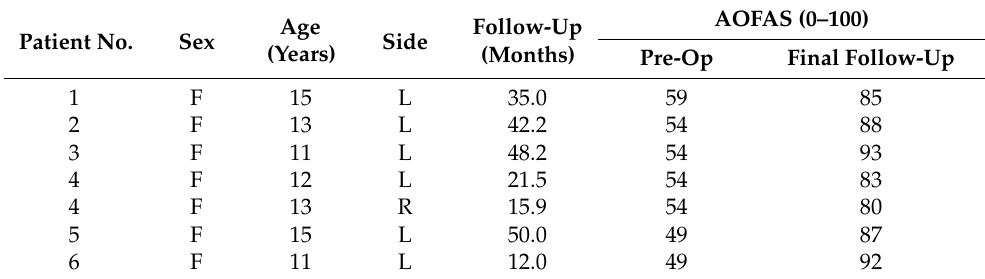
Table 1. Demographic